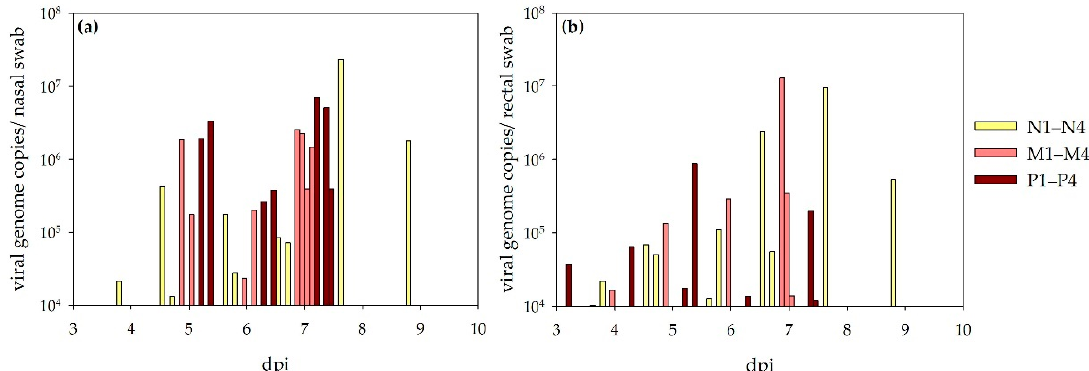
Figure 4. Virus shedding detected via RT-qPCR in sheep: results for nasal ( a ) and rectal swabs ( b ) are depicted. Viral RNA was detected as being steadier in nasal swab samples compared to rectal swab samples.